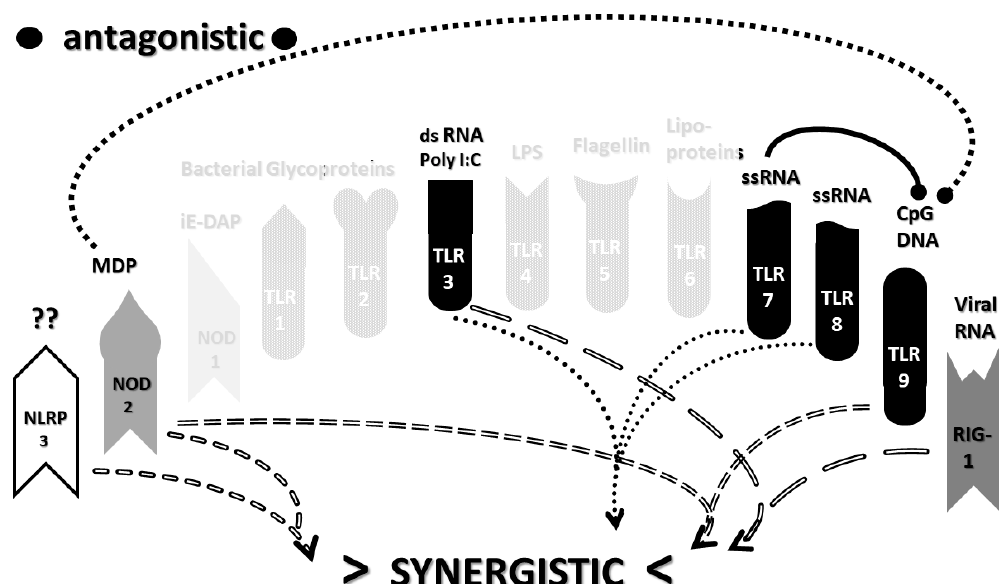
Figure 5. Consensus innate activation profile for coronavirus PAMPs based on the model in Figure 2A,B and data sum- marized in Table 2. TLR3, TLR7, TLR8, NOD2 and NLRP3 are activated, while the other receptors (faded) are not. The result is two pairs of synergistic interactions (arrows) beTable 3. and TLR7/8 and between NOD2 and NLRP3. No known antagonistic interactions are activated. Cytokine activation should be greater from coronaviruses than from rhinoviruses (Figure 4) but not significantly so, perhaps explaining why most coronavirus infections are asymptomatic or mildly symp- tomatic and associated with a cold or mild flu symptoms. See Tables 1 and 2 for abbreviations.